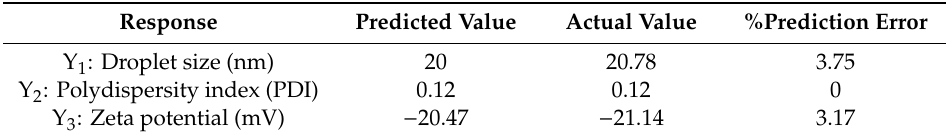
The theoretical predicted and actual experimental response values of the optimum nanoemulsions system ( n = 3).